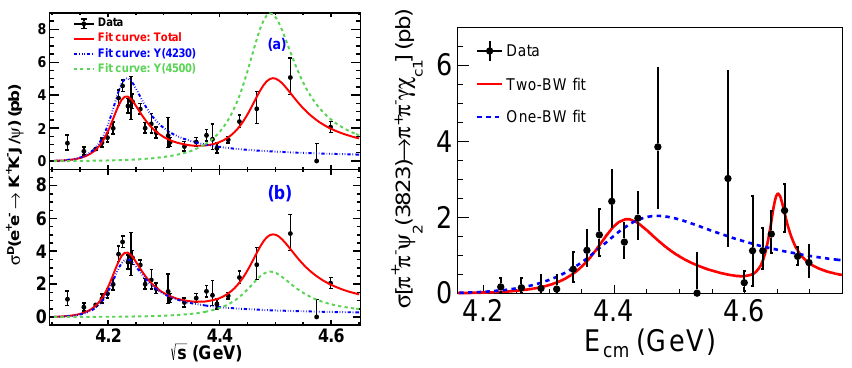
Figure 5. Fits to σ ( e + e − → K + K − J /ψ ) (Left panel, [39]) and σ [ e + e − → π + π − ψ 2 (3823)] × B [ ψ → γχ c 1 ] (right panel, 2 (3823)